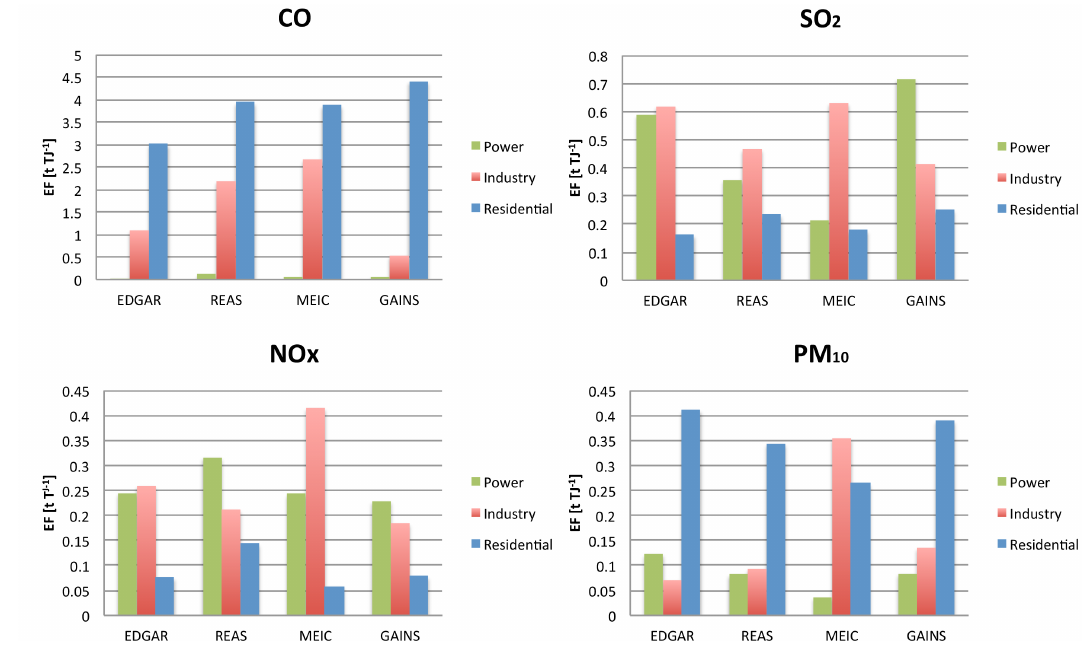
Figure 5. Net emission factors for CO, SO 2 , NO x , and PM 10 used among REAS and EDGAR for 2008, MEIC for 2010, and GAINS for 2005 for the three source